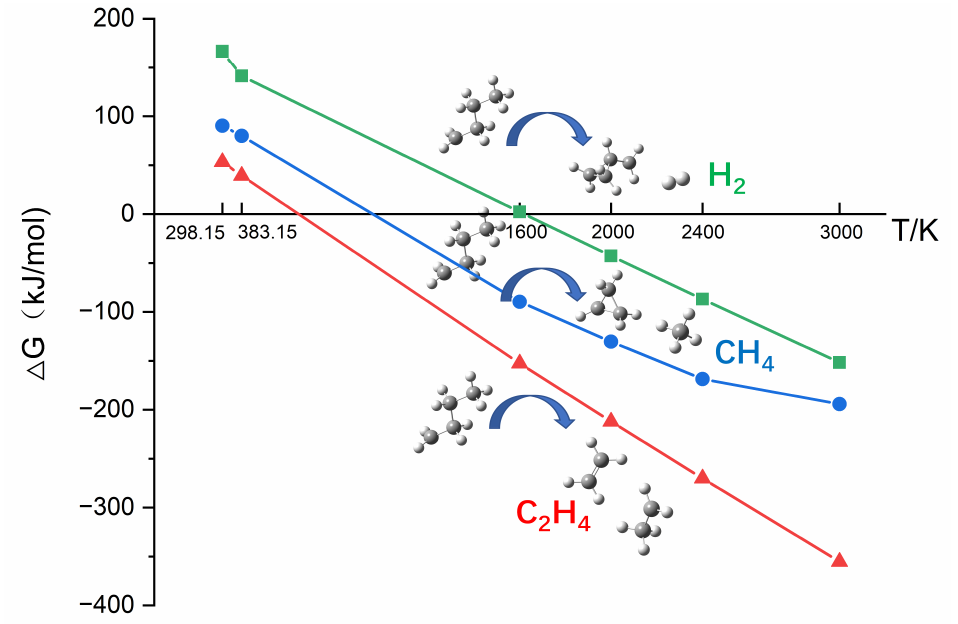
Figure 6. The Gibbs free energy changes at different temperatures: The generation of C 2 H 4 , CH 4 , and H